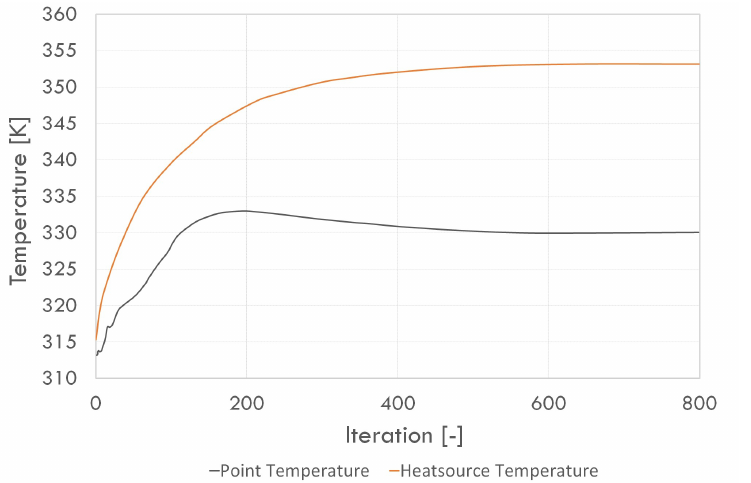
Figure 14. Dependence of the temperature behind the heat sink (point temperature) and the average temperature of the heat source during the calculation.